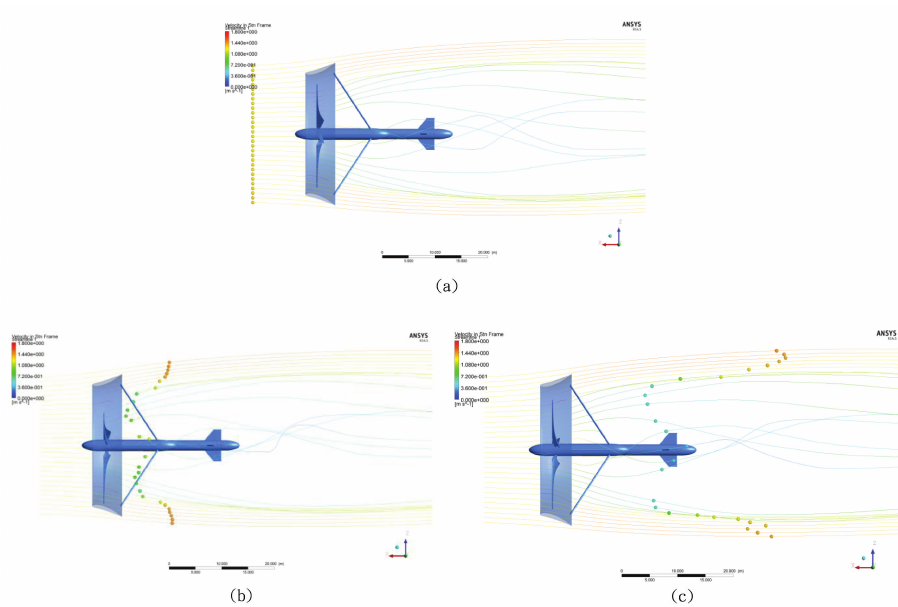
Figure 4. The streamlines in the wake region at: ( a ) t = 0 s; ( b ) t = 4 s; and ( c ) t = 8 s.